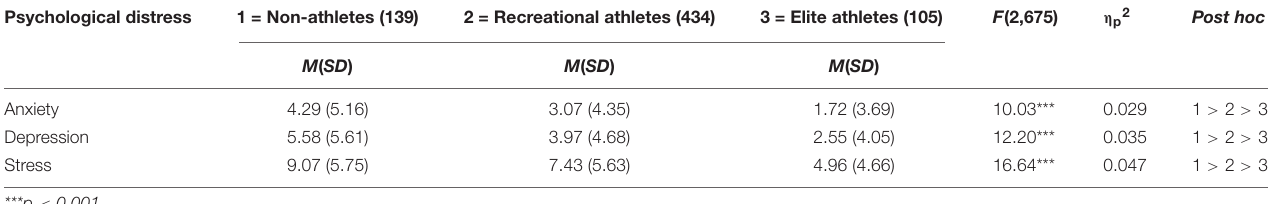
TABLE 2 | Results of one-way ANOVAs: differences in psychological distress during the curfew between non-athletes, recreational athletes, and elite athletes ( N = 678). Psychological distress 1 = Non-athletes (139) 2 = Recreational athletes (434)